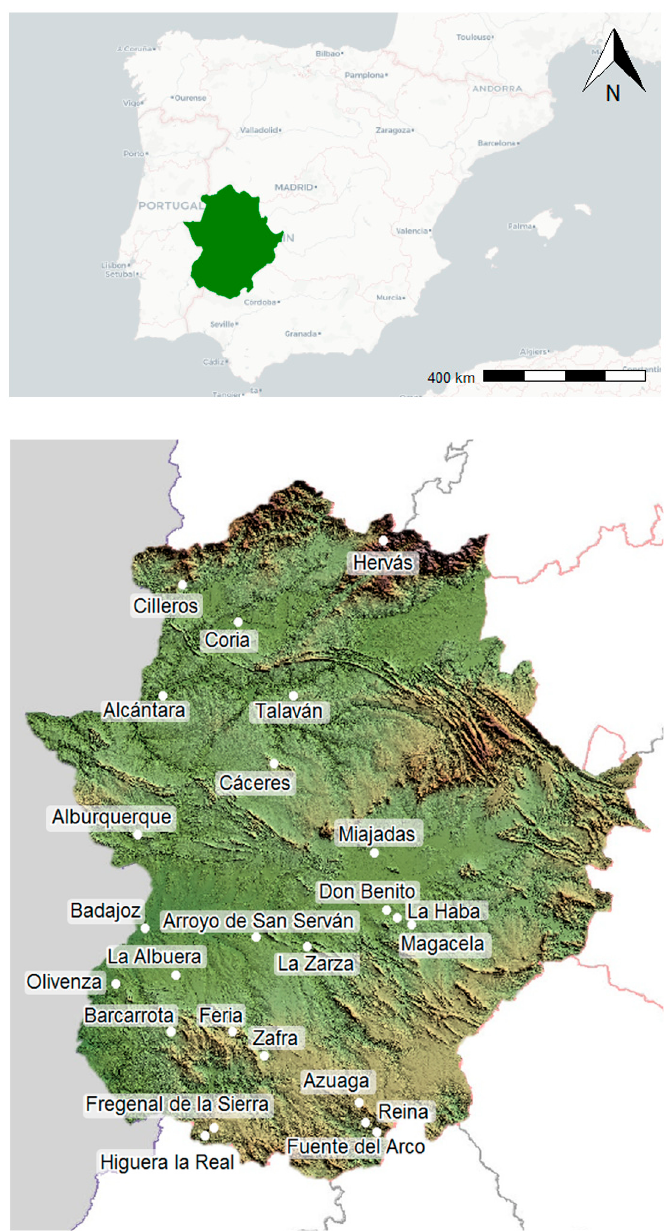
Figure 1. On top, the situation of the region of Extremadura in the Iberian Peninsula. On the bottom, map of Extremadura region (courtesy of Infraestructura de Datos Espaciales de Extremadura - IDE Extremadura) containing the locations where rogation ceremonies were celebrated.